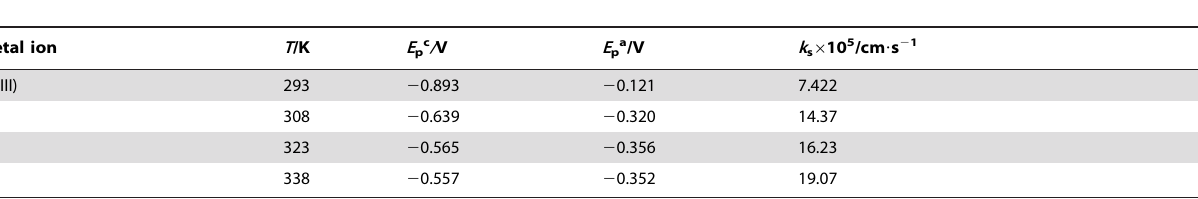
Table 3. Rate constants ( k s ), peak potentials ( E pc and E pa ) of Eu(III) in BmimBr at different temperatures. Metal